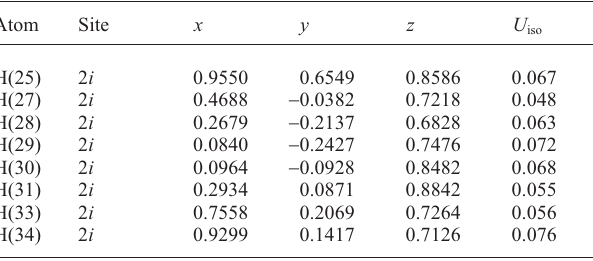
Table 3. Atomic coordinates and displacement parameters (in Å 2 )